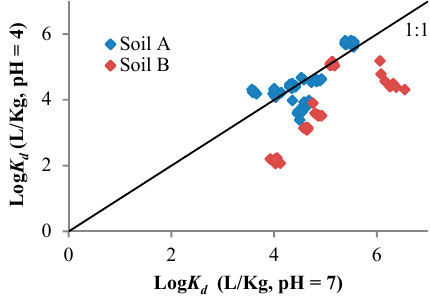
Figure 9. Comparison of heavy metal and metalloid (HM) partition coefficient (log K d ) calculated for soil A and soil B under neutral (pH = 7) and acid (pH = 4) rainfall conditions.